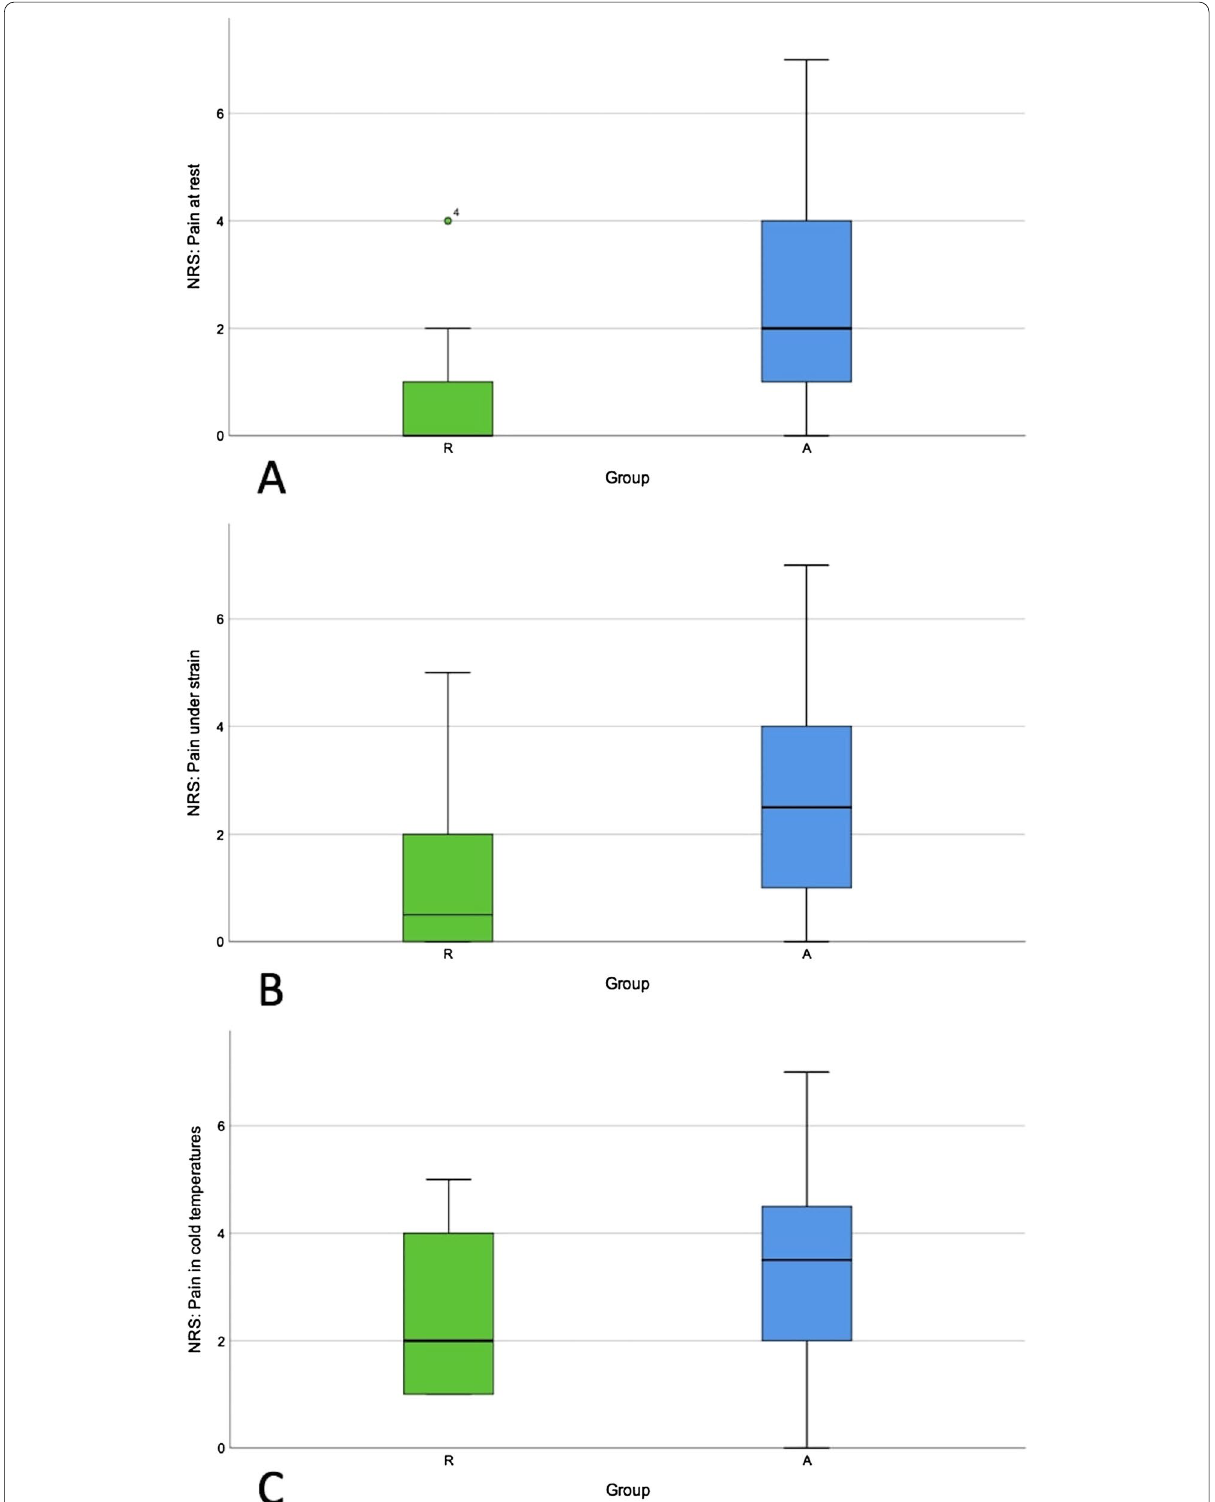
Fig. 6 Boxplots depicting the pain intensity according to the numerical rating scale at rest ( A ), under strain ( B ), and in cold temperatures ( C ) in groups R and